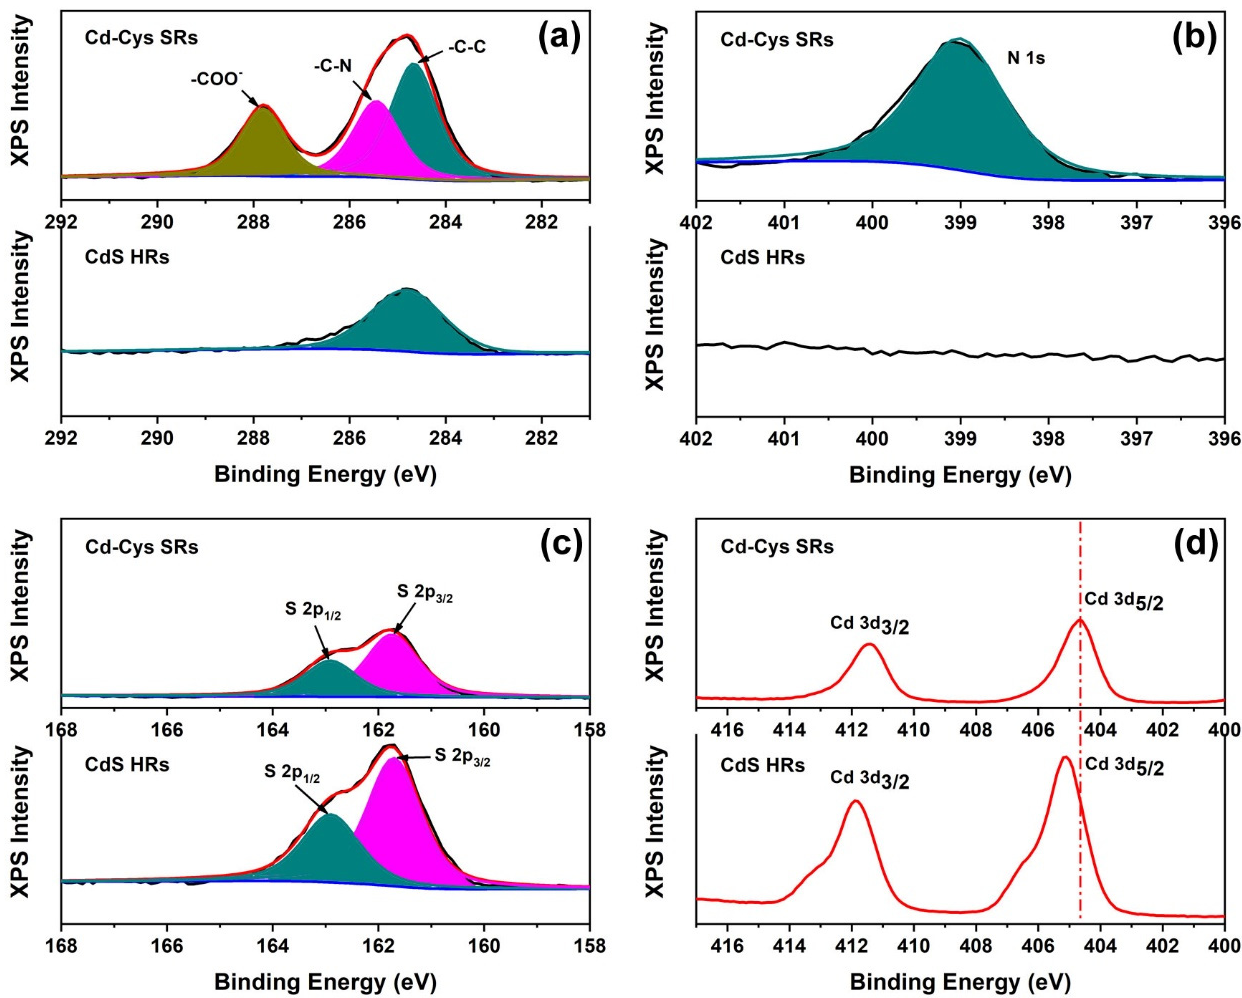
Figure 4. XPS patterns of C 1s ( a ), N 1s ( b ), S 2p ( c ), and Cd 3d ( d ) in samples before and after vulcanization.